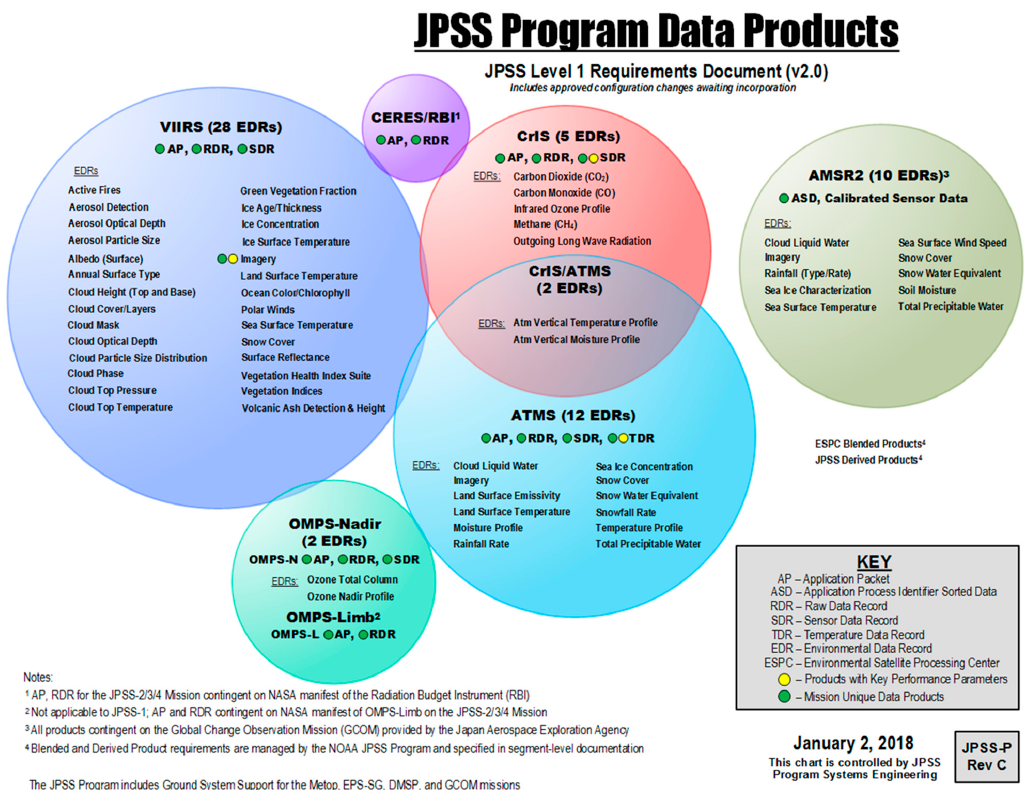
Figure 1. Sensor and Environmental Data (xDR) products from the S-NPP/NOAA-20/GCOM-W1 instruments